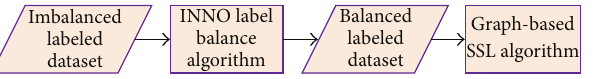
a balanced labeled dataset for learning methods. We inte- grate the proposed algorithm with two popular transductive graph-based SSL methods to perform a robust classification to imbalanced problem, and the processing flow can be described as Figure